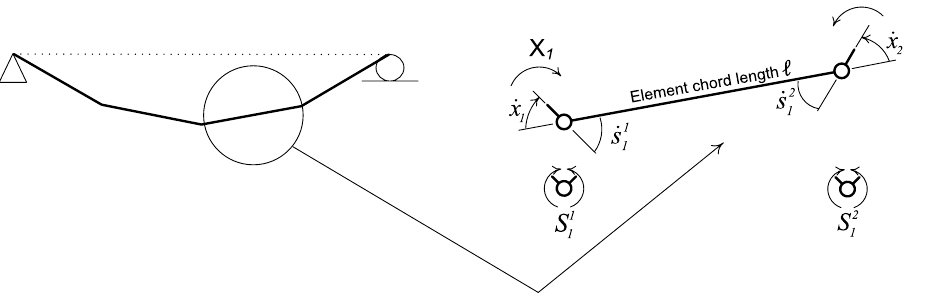
Figure 1. Stress-resultants, strain-resultant rates, chord deformation rates and independent chord forces in a element of a discretized